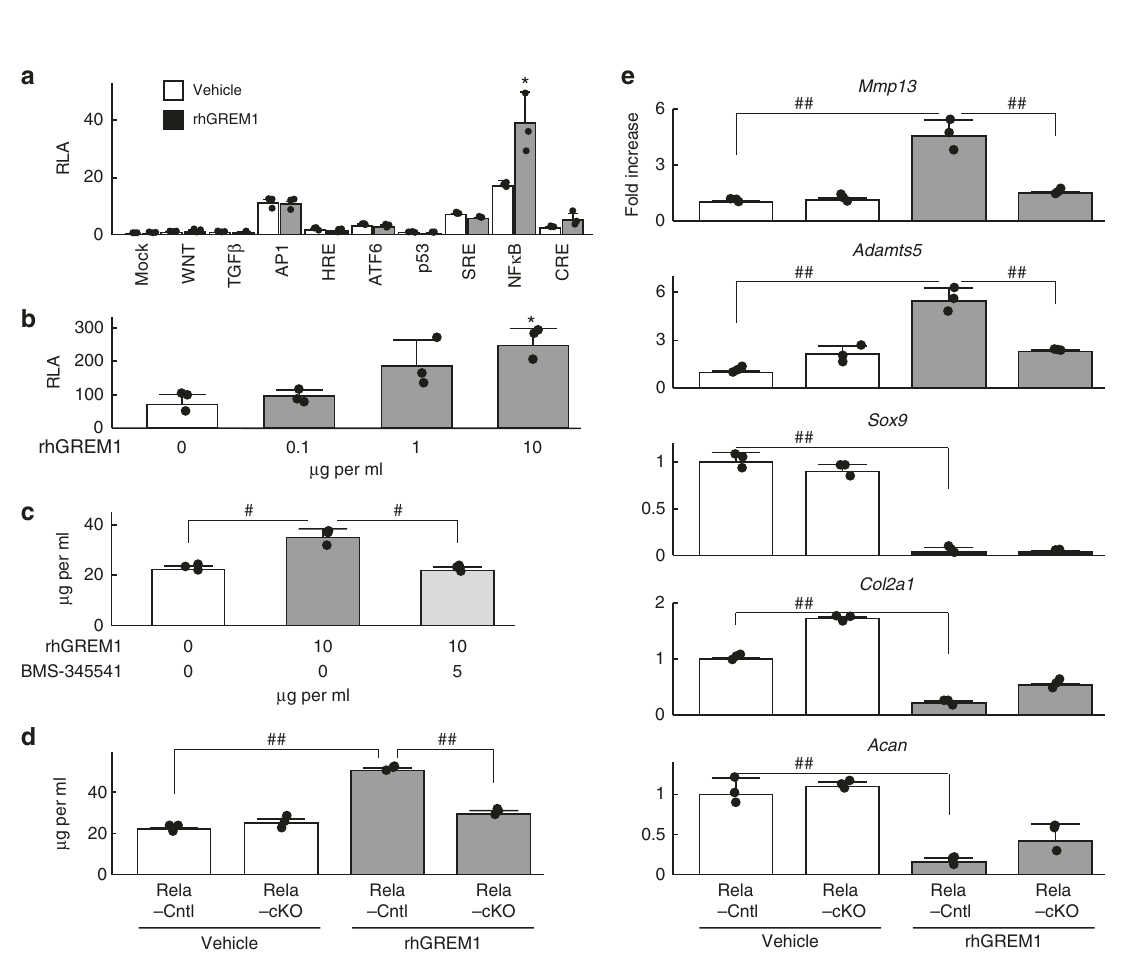
Fig. 5 NF- κ B signalling mediates the catabolic effects of gremlin-1. a Luciferase assay for screening of downstream signalling pathways of gremlin-1 using reporter vectors containing a response element for each pathway or transcription factor. * P < 0.05 versus each vehicle control (one-way ANOVA test). b Activities of luciferase reporter vectors containing an NF- κ B motif with rhGREM1 treatment. * P < 0.05 versus 0 (vehicle) (one-way ANOVA test). c Amount of proteoglycan released into culture medium from wild-type mouse femoral heads cultured with or without rhGREM1 (10 µ g/mL) and IKK inhibitor BMS-345541 (5 µ M) for 3 days. # P < 0.005 (one-way ANOVA test). d Amount of proteoglycan released into culture medium from RelA fl /